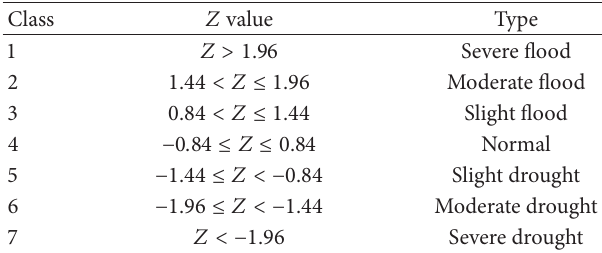
Table 1: Flood and drought classification based on the 𝑍 index